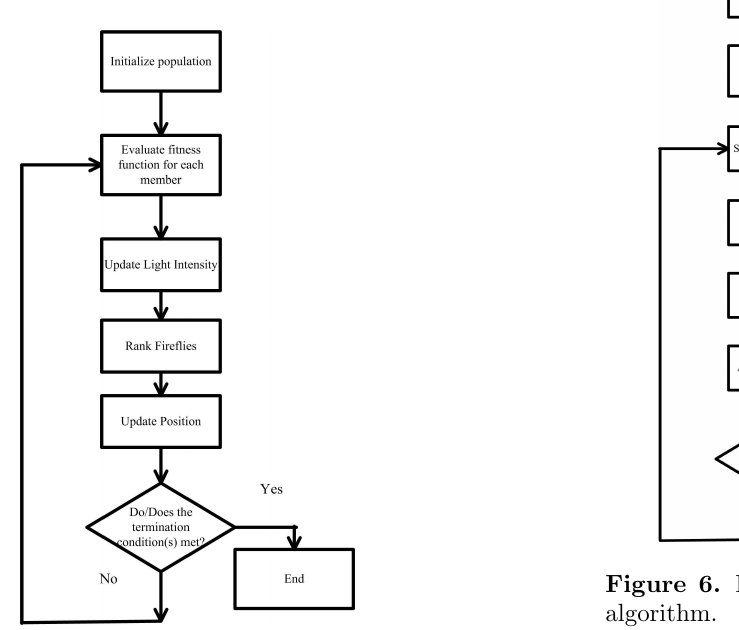
Figure 5. Flow-diagram of firefly al- gorithm.